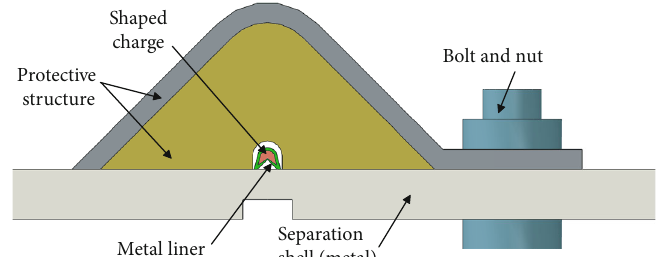
Figure 1: General aerospace separation